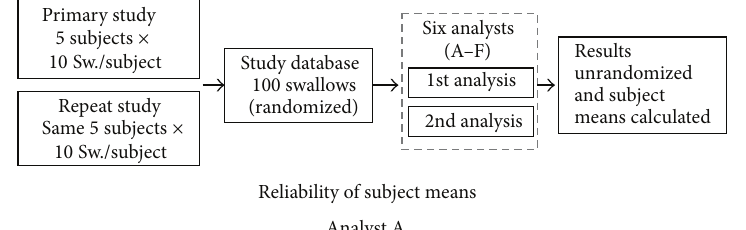
A discrete hypopharyngeal peak pressure was also obtained at 1 cm proximal to the UES apogee position